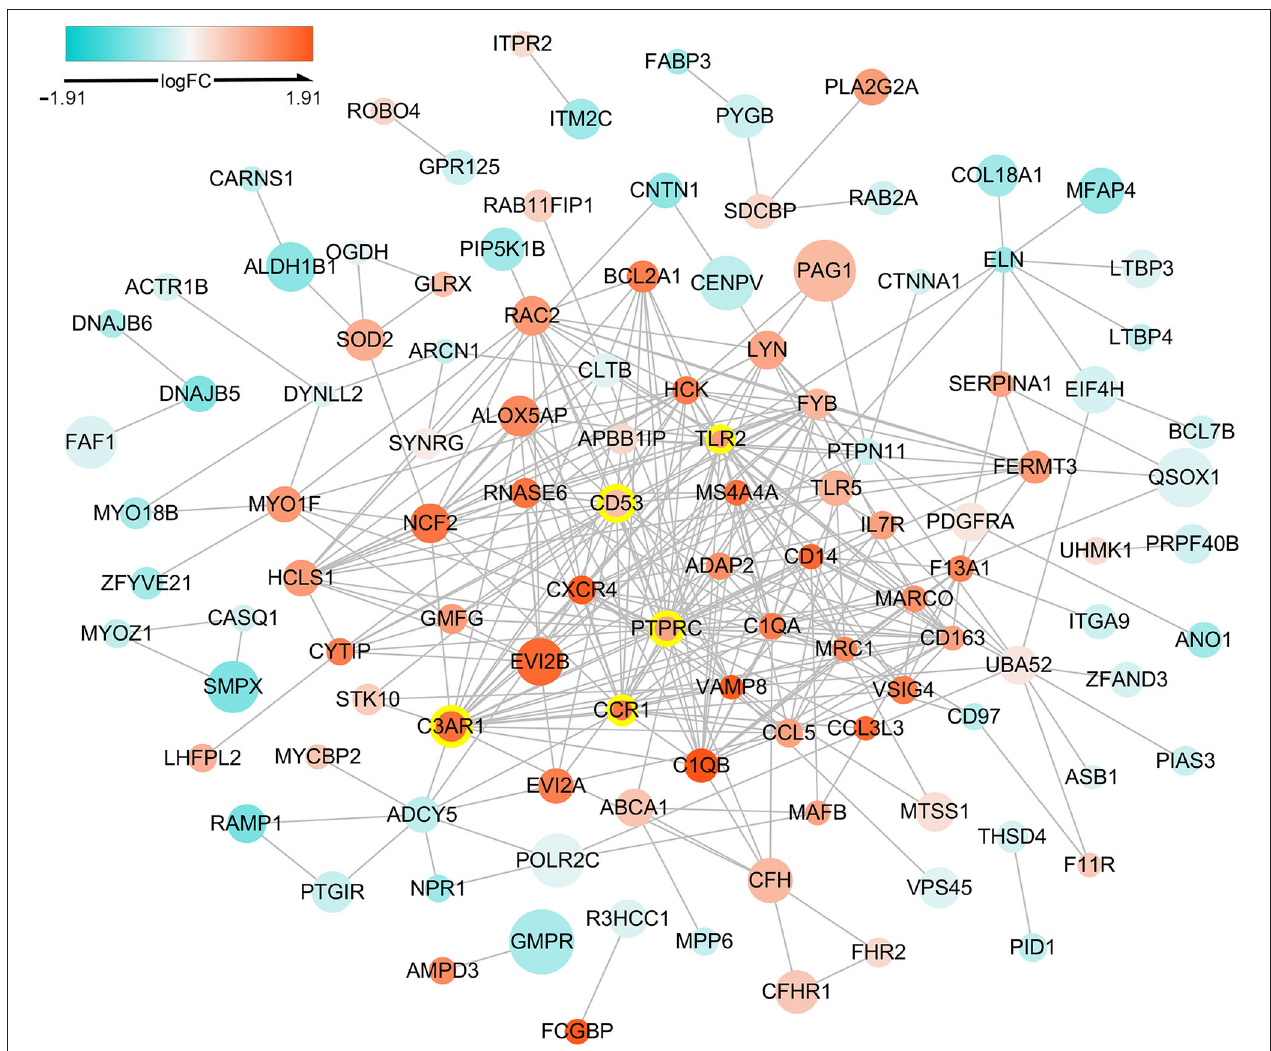
FIGURE 2 | Protein-protein interaction network for the DETregRGs. The node size stands for the Pearson correlation coefficient of a certain gene with Tregs abundance. The nodes with yellow outlines represent hub genes. DETregRGs, differentially expressed Tregs-related genes; FC, fold